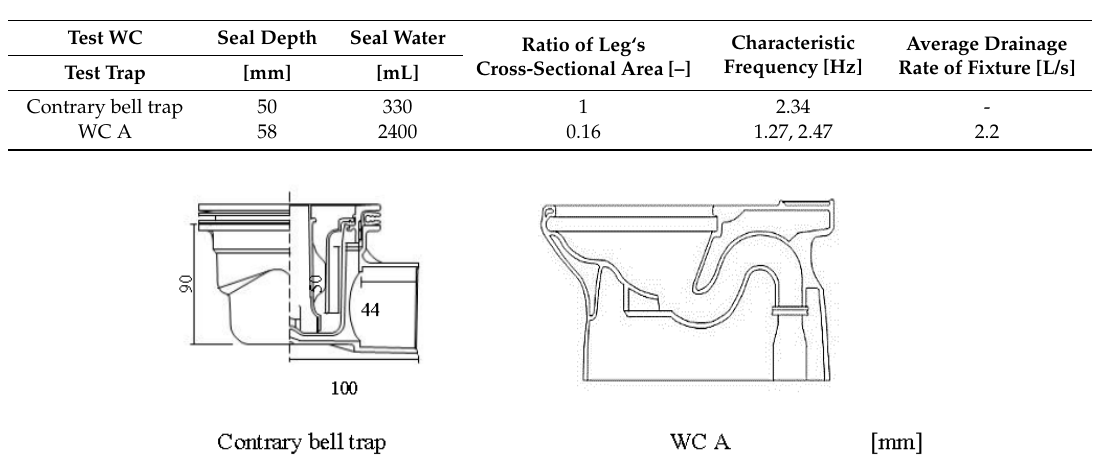
Table 2 . Specifications of measurement devices.